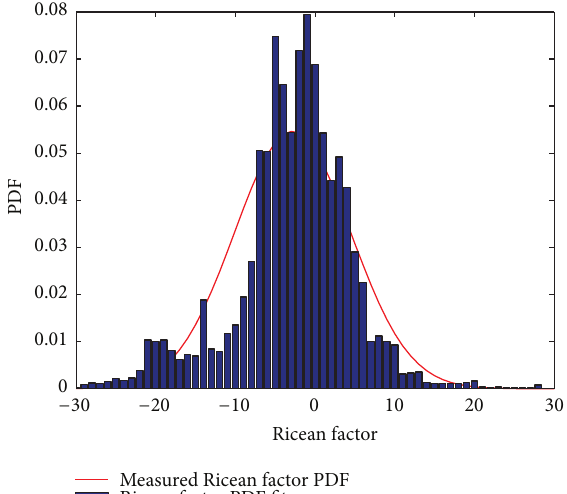
Figure 5: Ricean factor model in LOS segment.